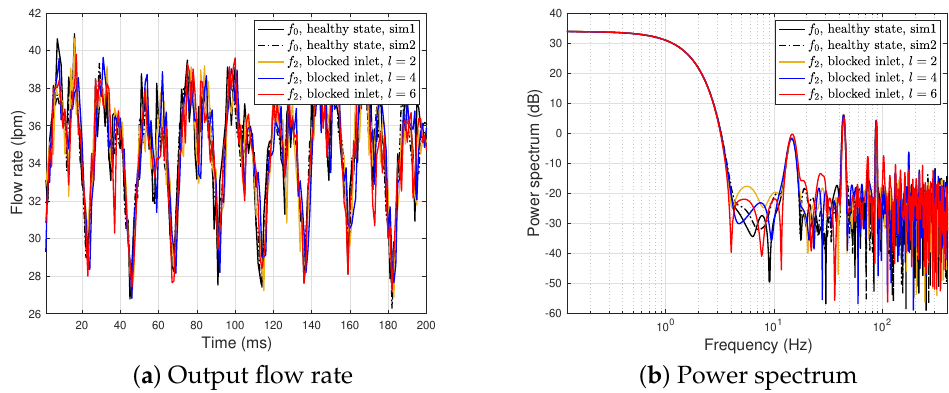
Figure 5. Output flow rate and power spectrum of f 0 and f 1 with different severity levels, l =